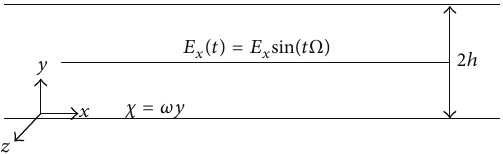
Figure 1: The flow channel and coordinate system